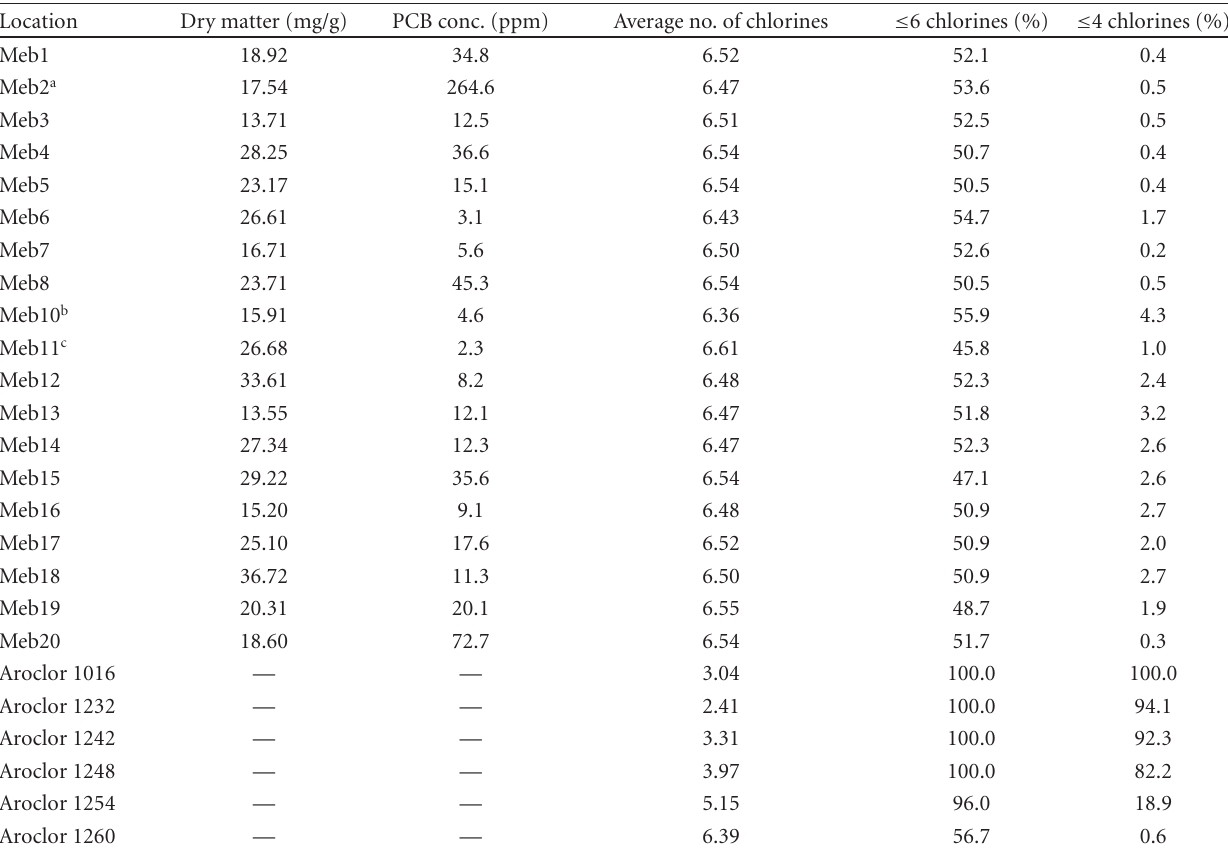
Table 1: Analyses of the dry matter content, the total PCB concentration, the average number and percentage of chlorines less than 4 and 6, respectively, and in soil samples and commercial Aroclor mixtures [40]. a,b,c refer to the homolog distribution profiles, where a is the most typical distribution, b is the most dechlorinated, and c is the least dechlorinated among the soil analyzed soil samples. Sample Meb9 was not